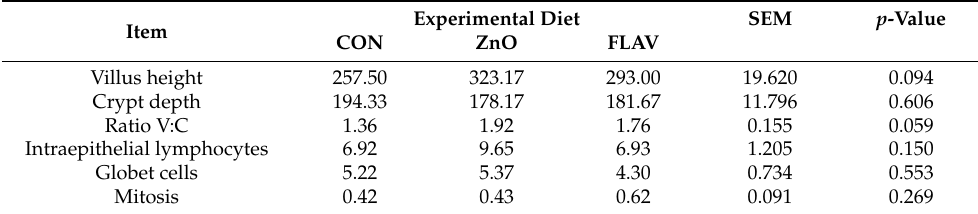
Figure 8. Differentially abundant taxa (Ln change) between a diet supplemented with antimicrobial compounds (ZnO) and a diet supplemented with flavonoid compounds (FLAV). Positive values (green color) and negative values (red color) indicate greater and lower abundance, respectively. Taxa are sorted by level of significance (from higher to lower). Only significant taxa are presented ( p- value < 0.10). Data are means of 6 replicate pens for the main effect of level (one pig per replicate pen was sampled).